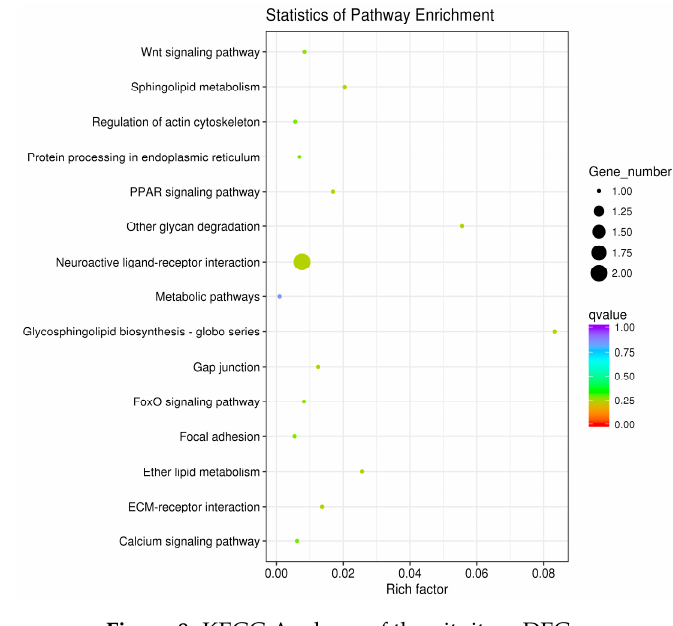
Animals 2020 , 10 , x FOR PEER REVIEW Figure 8. KEGG Analyses of the pituitary DEGs. Figure 8. KEGG Analyses of the pituitary DEGs.